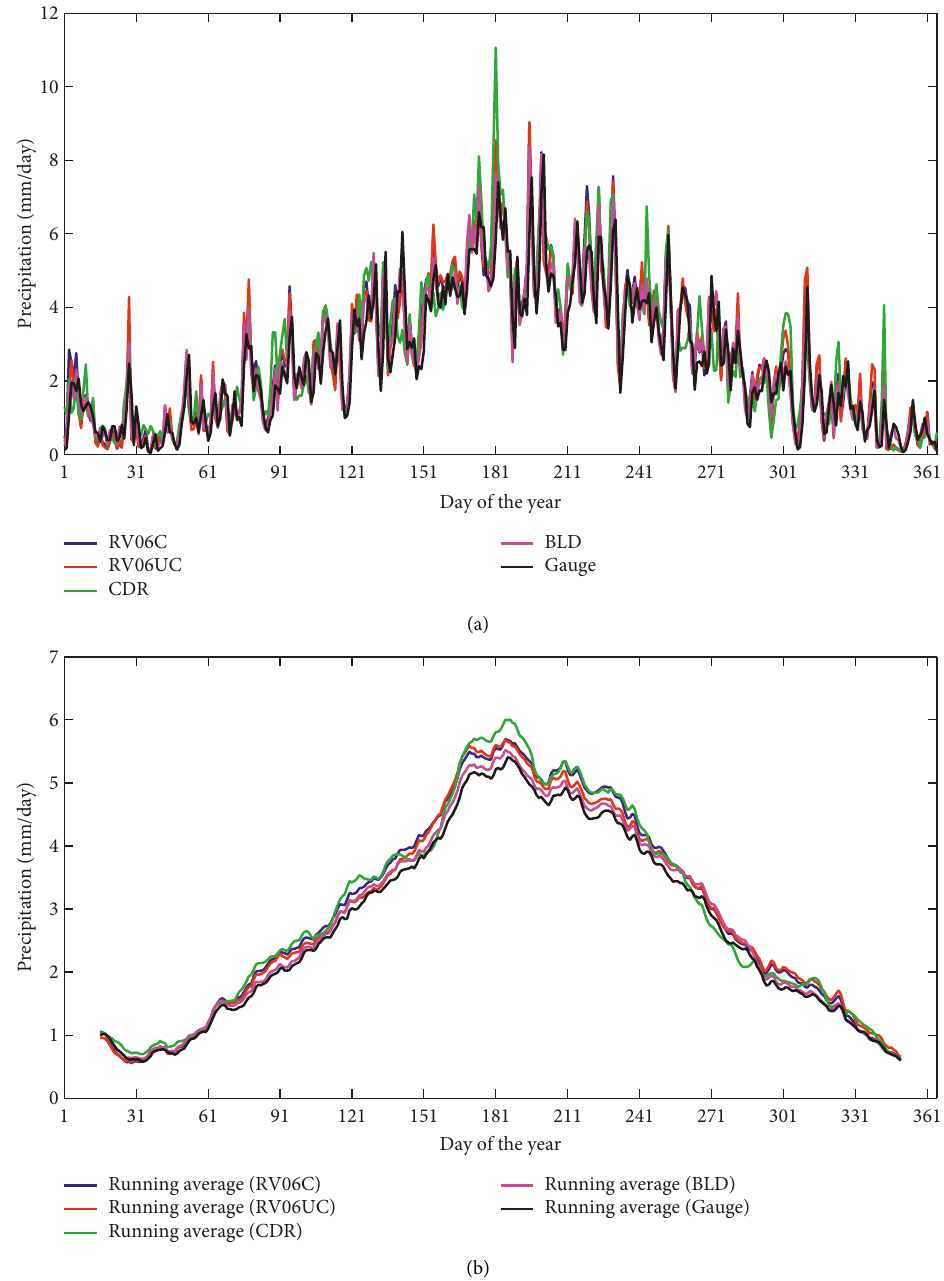
Figure 3: Comparison of average daily precipitation time series derived from the four SPPs and the corresponding gauge observations over Mainland China during the period from March 2014 to June 2018 (a). A 31-day moving average is utilized to each average daily precipitation time series to reduce visual cluttering